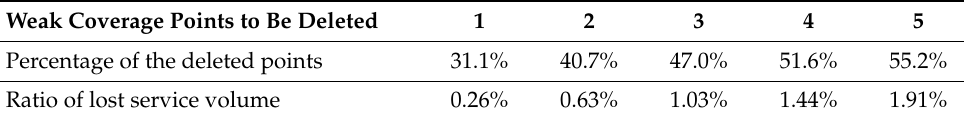
Table 1. Traffic loss results after filtering some weak signal coverage points. Weak Coverage Points to Be Deleted